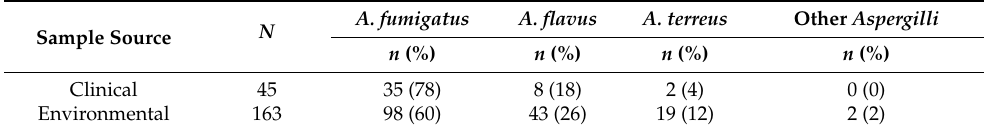
Table 1. Species distribution of Aspergillus spp. recovered from clinical and environmental samples.